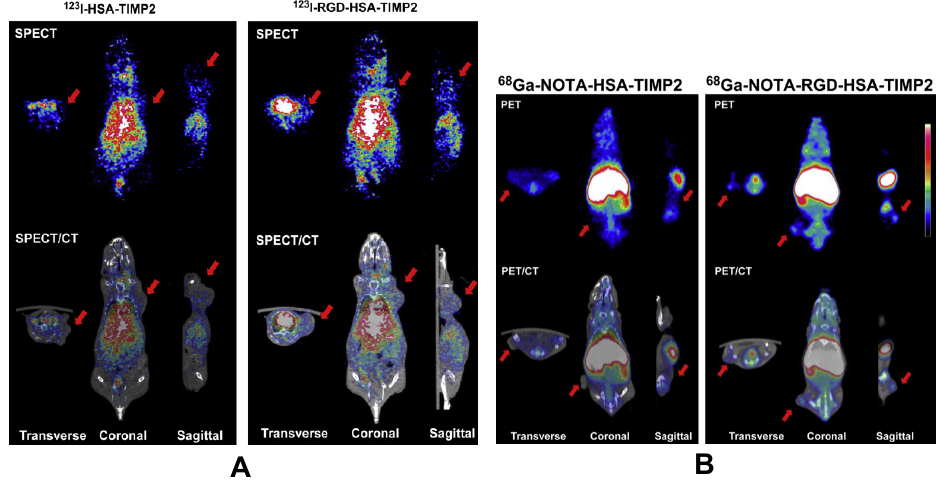
Figure 4. The SPECT and SPECT/CT images of 123 I-HSA-TIMP2 ( A , left ) and 123 I-RGD-HSA-TIMP2 ( A , right ) and the PET and PET/CT images of 68 Ga-NOTA-HSA- TIMP2 ( B , left ) and 68 Ga-NOTA-RGD-HSA-TIMP2 ( B , right ). Red arrows indicated the U87MG tumor. Reprinted with permission from [21].